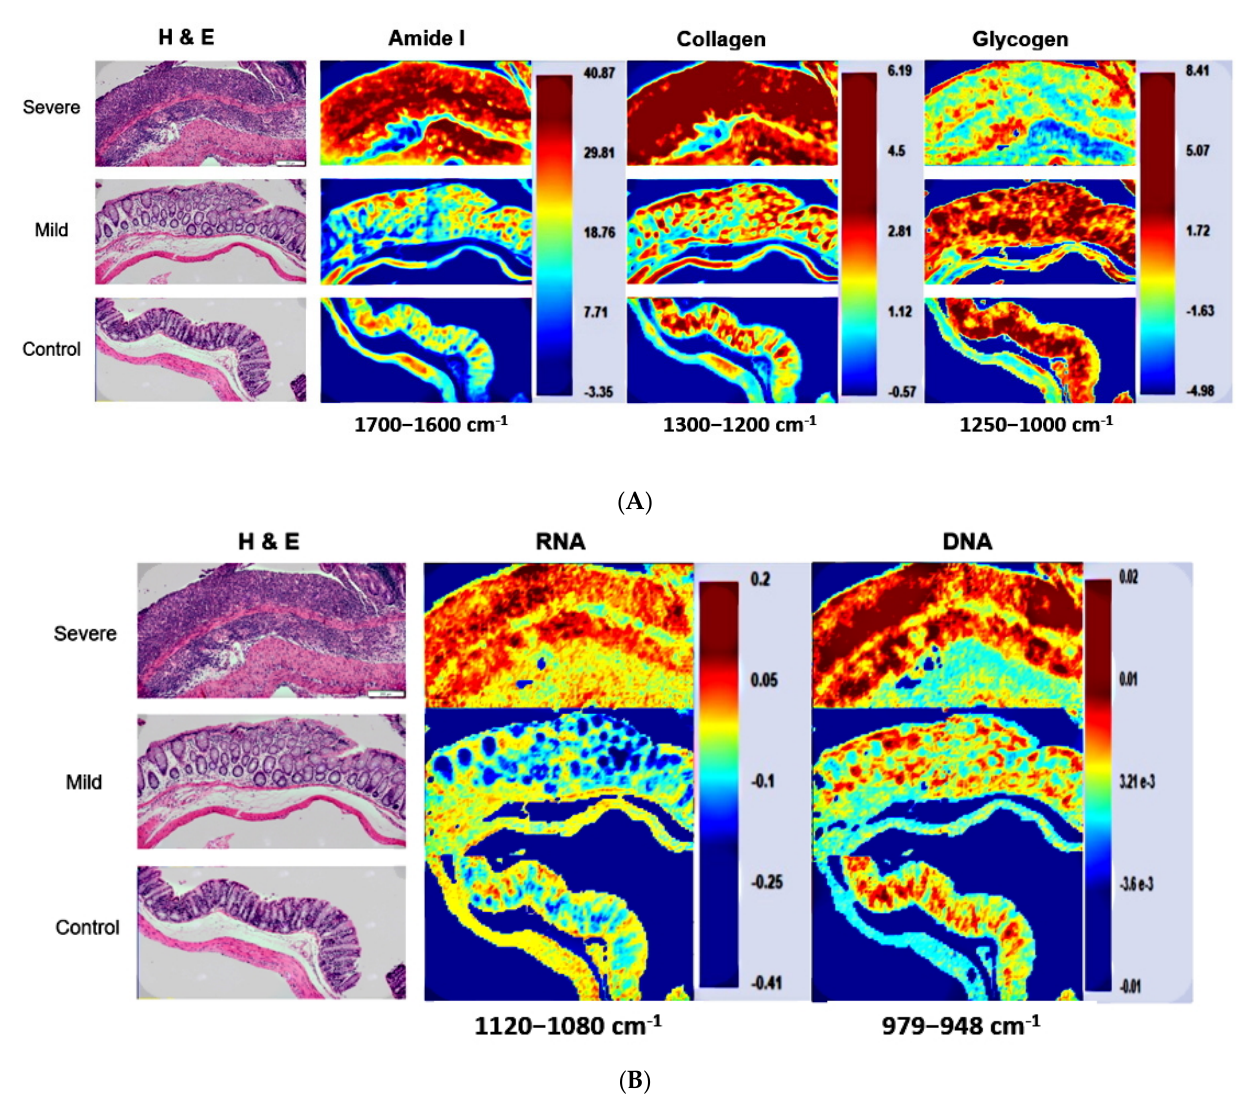
Figure 2. Comparison of the integrated areas under regions of interest in the spectra in healthy tissue, mild, and severe colitis. ( A ) Quantitative representation of protein, collagen, and glycogen. ( B ) Quantitative representation of RNA and DNA.